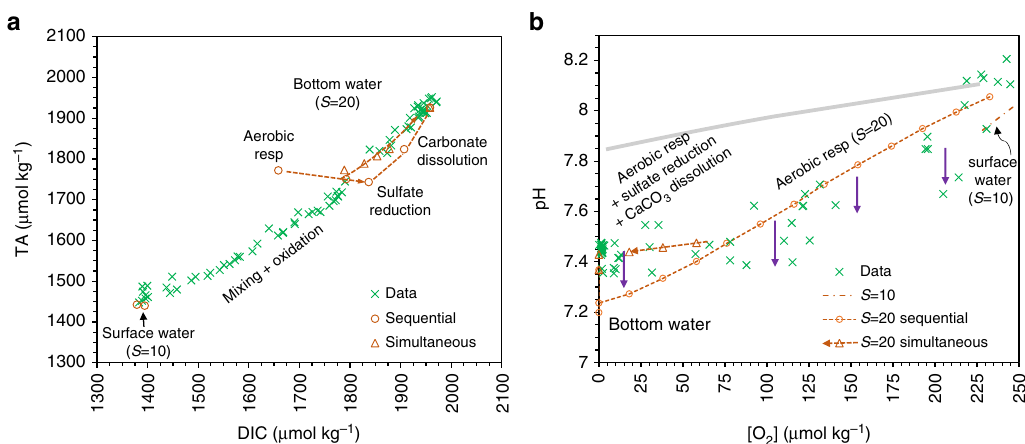
Fig. 4 Model simulations of the evolution of total alkalinity, dissolved inorganic carbon, pH, and O 2 during biogeochemical processes. a Total alkalinity ( TA ) and dissolved inorganic carbon ( DIC ) relationship and b pH (25 °C and NBS scale) and [O 2 ] relationship. The biogeochemical pathway, or TA and DIC loci, includes aerobic respiration ( AR ), sulfate reduction ( SR ) and CaCO 3 dissolution ( CD ). Predicted pH or TA values are provided together with observed pH or TA (calculated from pH and DIC data from August 2013). Both sequential ( open circles ) and simultaneous ( triangles ) pathways are presented. Purple arrows represent acidi fi cation generated by oxidation of reduced chemicals (H 2 S). The light shaded line at the top indicates the pH and [O 2 ] relationship from the Gulf of Mexico re fl ecting aerobic